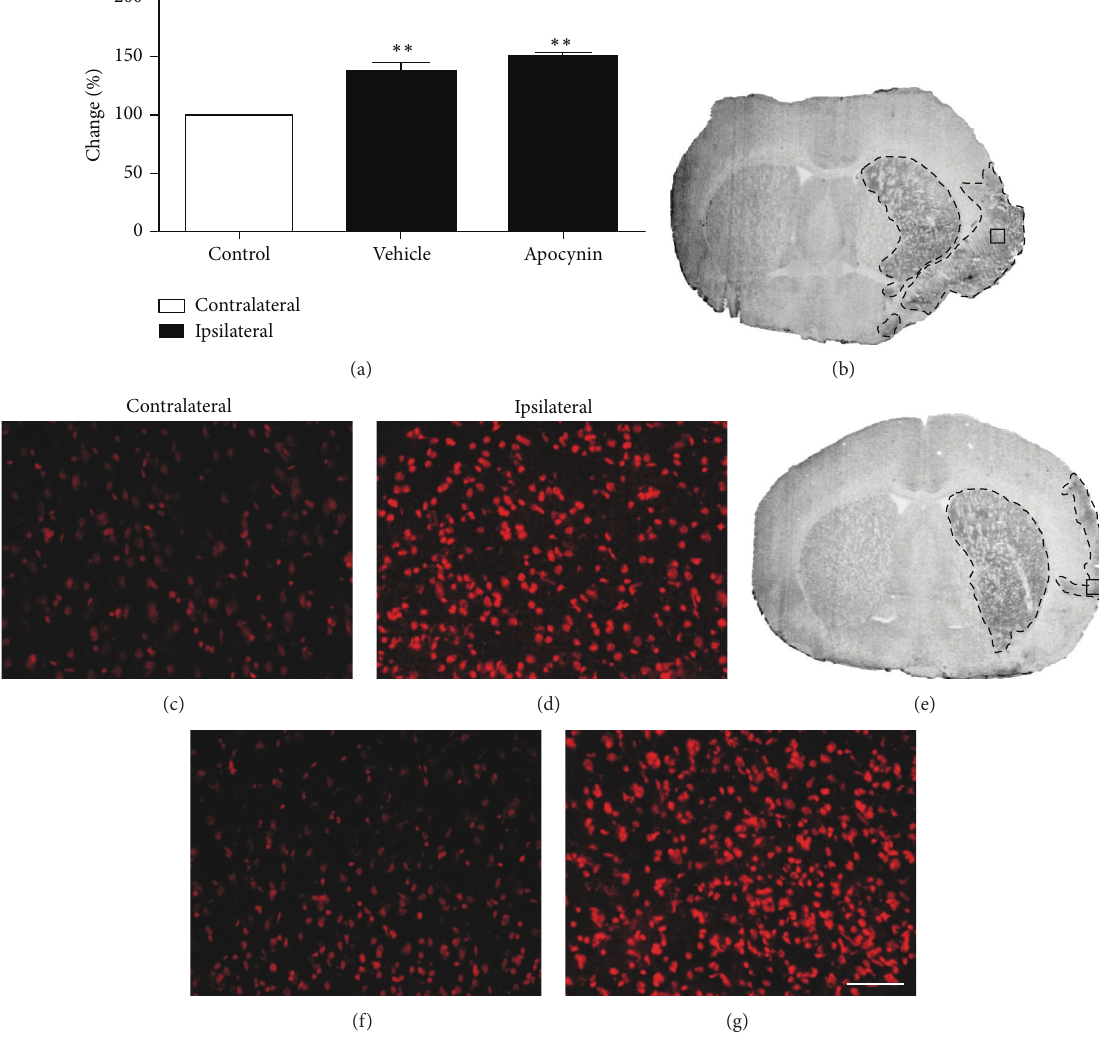
F 3: �uanti�cation of superoxide production from all cells in the core infarct region detected in situ 3 days aer stroke in the ipsilateral cortex (stroke affected; solid bars) compared with the contralateral cortex (nonaffected; open bar) following ischemic stroke in vehicle control and apocynin-treated rats (a). �ore infarct regions of the cortex were identi�ed using M�ID images generated from unstained forebrain sections adjacent to those analy�ed for superoxide, in vehicle control rats (b) and apocynin-treated rats (e). Representative �uorescence micrographs of sections incubated with superoxide-sensitive dihydroethidium in vehicle control ((c), (d)) and apocynin- ((f), (g)) treated rats from the ipsilateral cortex ((d), (g)) and the contralateral mirror image ((c), (f)). Relative �uorescence was �uanti�ed by tracing around P individual cells and analysed using ImageJ soware. Data are presented as mean SEM ( n = 11 apocynin treated; n = 9 vehicle treated). 0.01 versus contralateral control (ANOVA). Scale bar = 100 ∗∗ ± < 𝜇𝜇